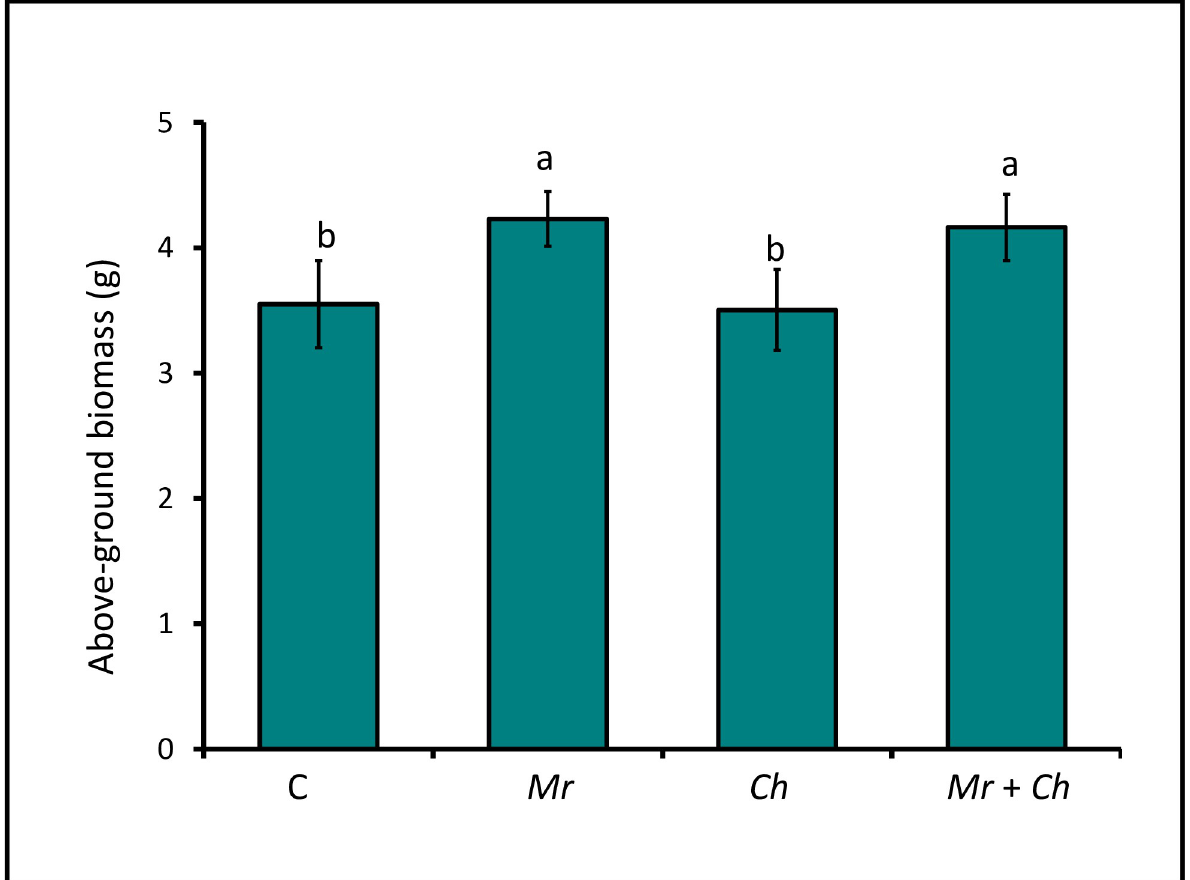
Fig 2. Above-ground biomass of V4 maize. End-of-experiment mean aboveground biomass of maize in the M . robertsii (Mr), C . heterostrophus (Ch), M . robertsii + C . heterostrophus (Mr + Ch) treatments and untreated control (C) (F 3,129 = 6.05; P = 0.0007). Values are untransformed means ± SEM; different letters indicate significant differences at α =